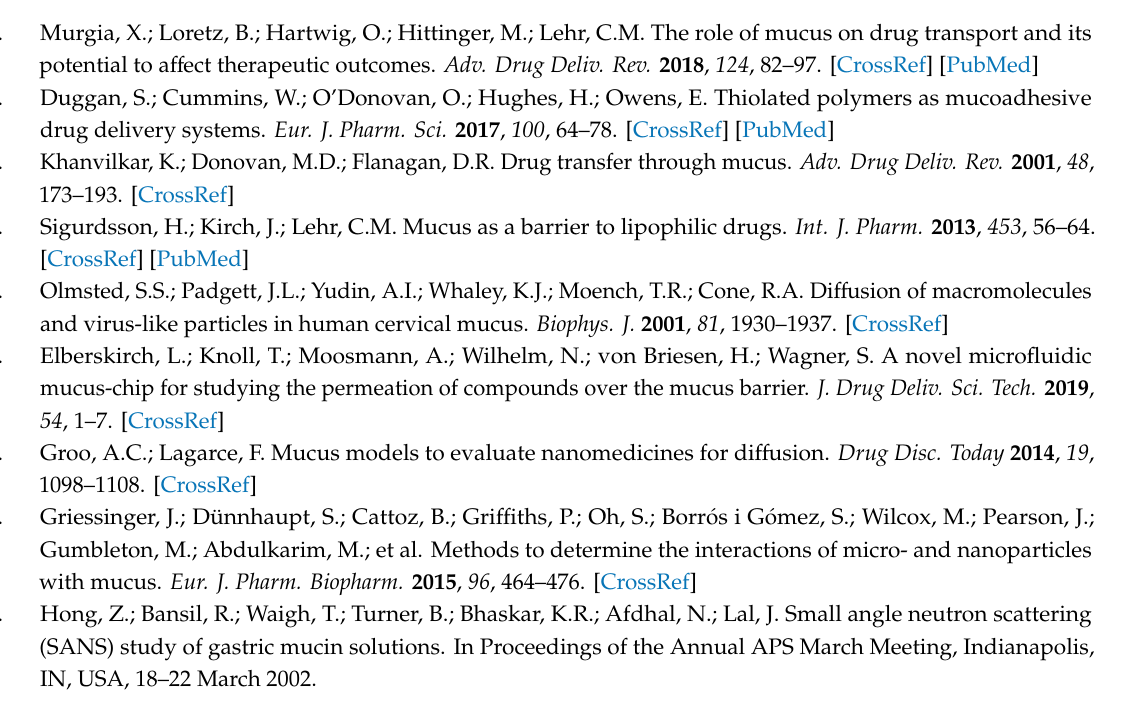
Figure S1: Di ff usion profiles of naproxen (NPR) in water ( A ), MUC 0.1 ( B ), 0.3 ( C ) and 0.6% ( D ) ( w / w ). In this figure the drug concentration (C) has been normalized over the nominal concentration of the drug in the cuvette at the beginning of the experiment (C 0 ), Figure S2: Di ff usion profiles of atenolol (ATN) in water ( A ), MUC 0.1 ( B ), 0.3 ( C ) and 0.6% ( D ) ( w / w ). In this figure the drug concentration (C) has been normalized over the nominal concentration of the drug in the cuvette at the beginning of the experiment (C 0 ), Figure S3: Di ff usion profiles of hydrocortisone (HYD) in water ( A ), MUC 0.1 ( B ), 0.3 ( C ) and 0.6% ( D ) ( w / w ). In this figure the drug concentration (C) has been normalized over the nominal concentration of the drug in the cuvette at the beginning of the experiment (C 0